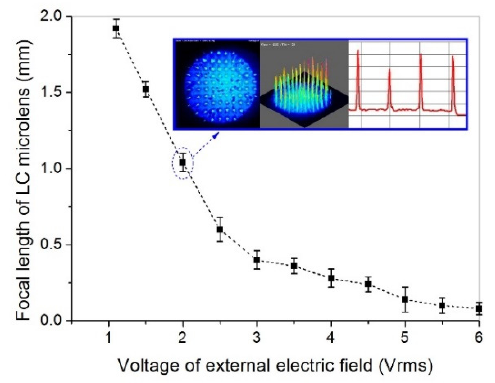
Figure 8. Relationship between the focal length of the LC microlens and the voltage of the external electric field loaded on the LC microlens. The built-in diagram is the 2D image, 3D image, and point spread function (PSF) of the LC microlens under the voltage of 2.0 Vrms.